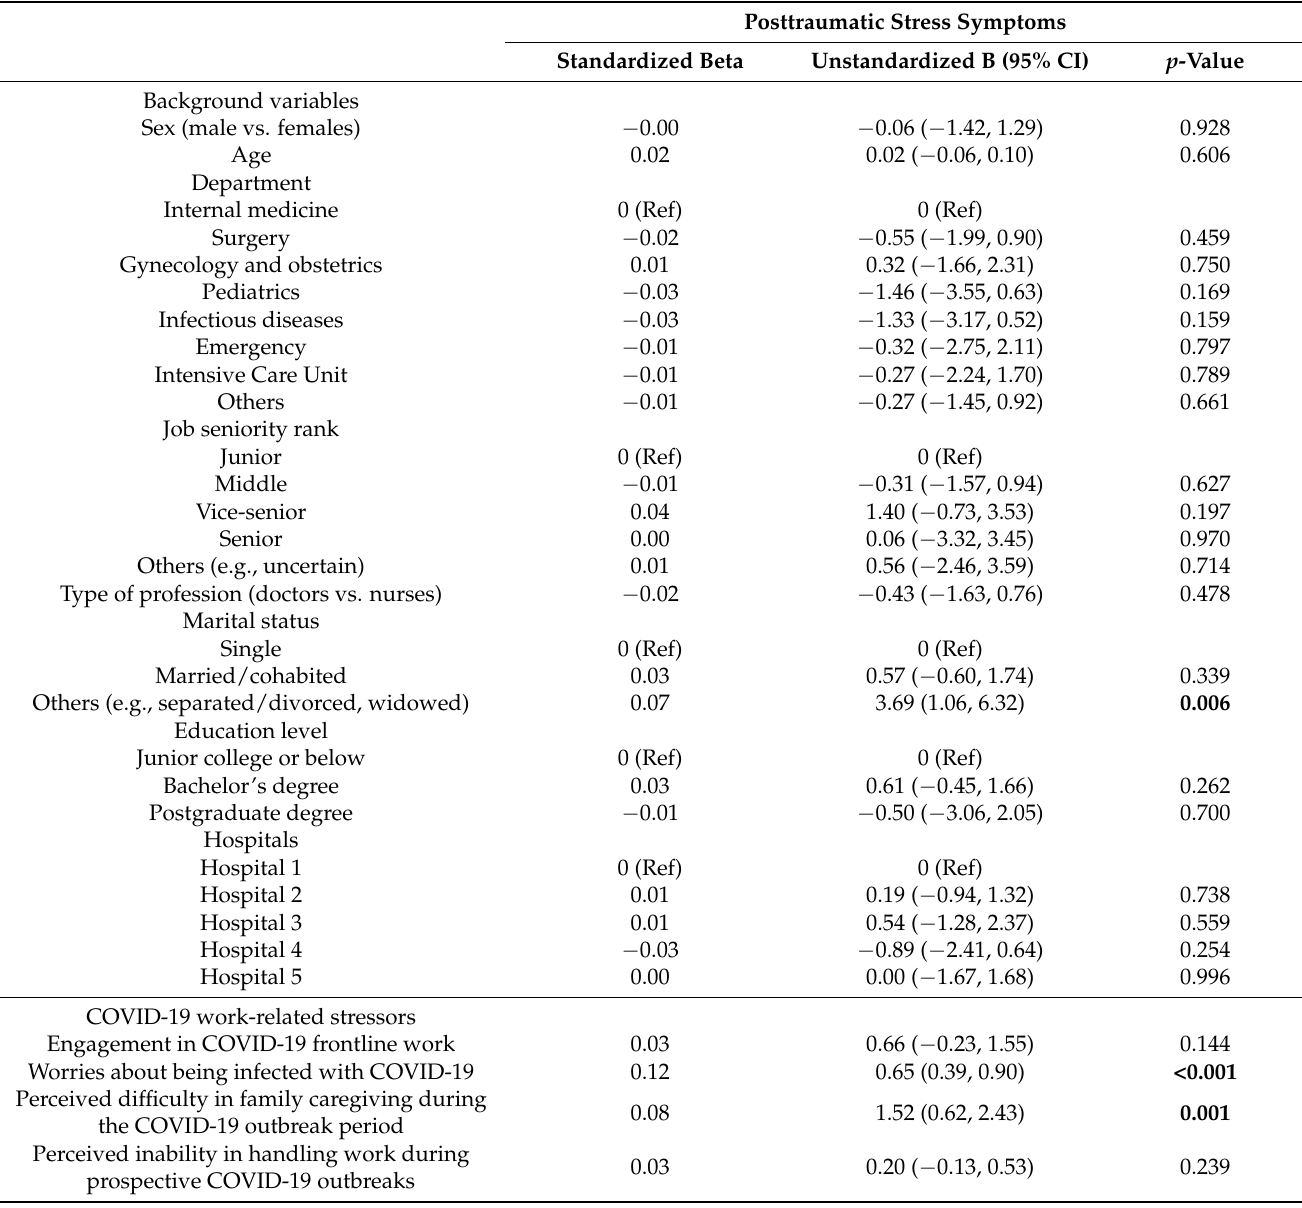
Table 2. Multivariable associations between the studied variables and